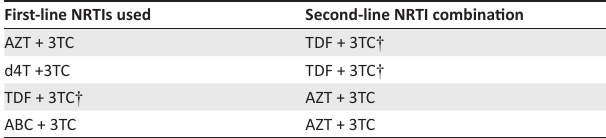
FIGURE 1: Indications for doing a resistance test on second-line antiretroviral